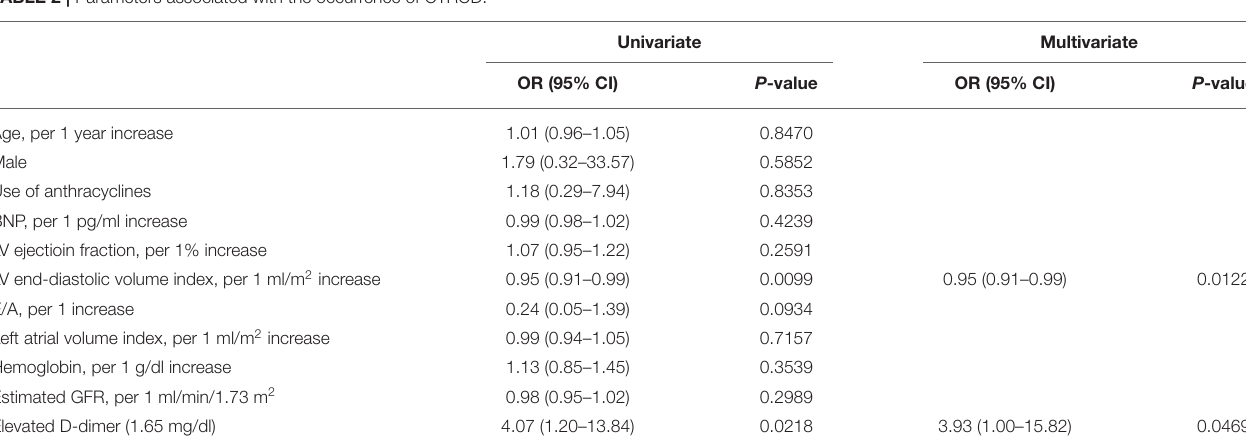
TABLE 2 | Parameters associated with the occurrence of